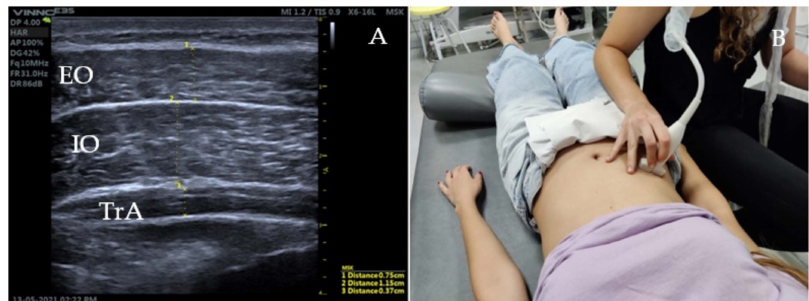
Figure 3. Ultrasound image and ultrasonography of the lateral musculature of the abdominal wall. ( A ) corresponds with the thickness of the lateral abdominal muscles at rest. ( B ) demonstrates the lineal transducer position between the costal cartilage of the eleventh rib and the iliac crest.